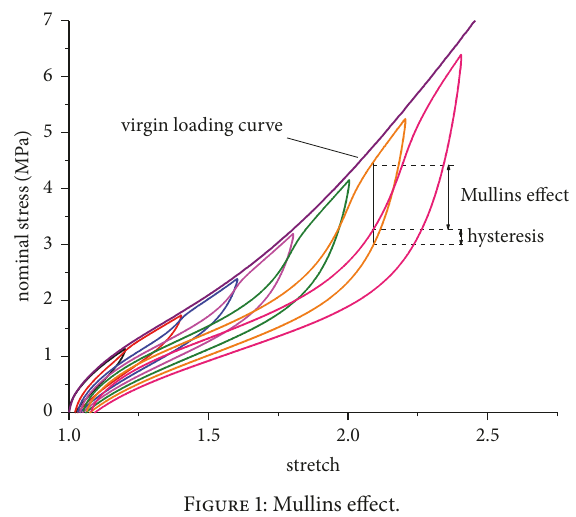
Figure 1: Mullins